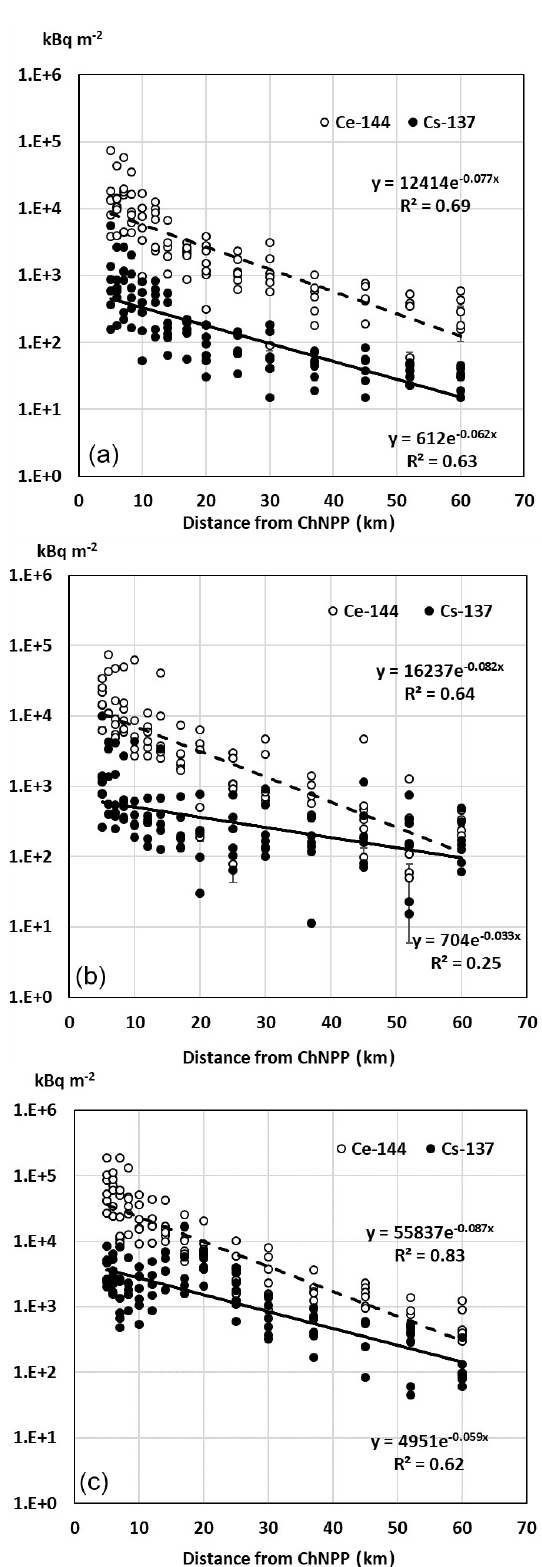
Figure 5. Relationship between fallout density of 144 Ce (1) and 137 Cs (2) and distance from the ChNPP towards the south (a) (150– 210 ◦ ), the west (b) (240–300 ◦ ) and the north (c) (330–30 ◦